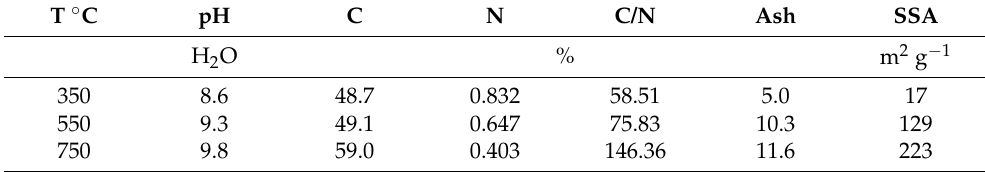
Table 1. Selected properties of sugarcane straw biochar at different pyrolysis temperatures. T ◦ C pH C N C/N Ash SSA H 2 O